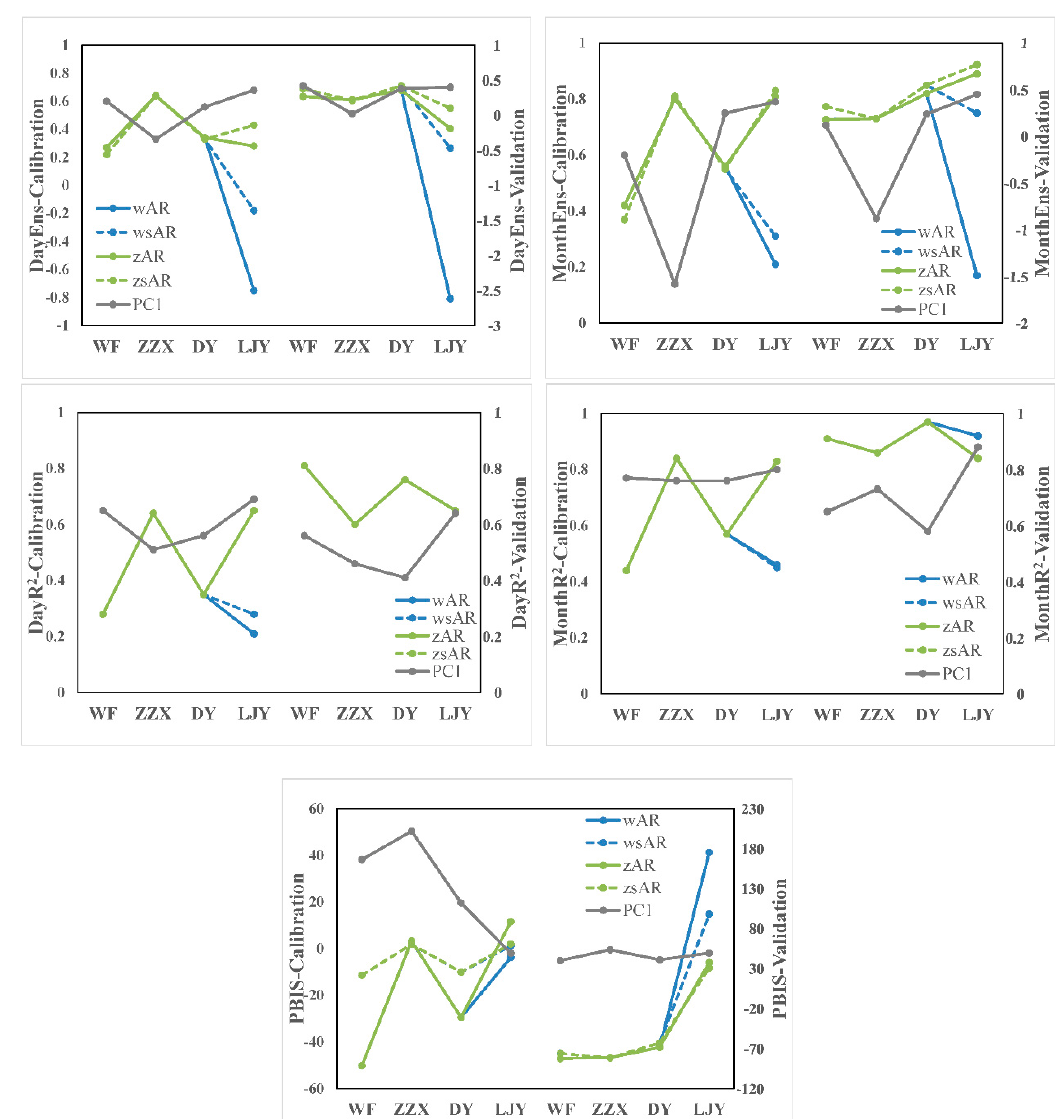
Figure 4. The variation of the area ratio method performance in the four gauged catchments in group PC1. wAR referred to the non-standard area ratio (AR) method when the runoff donor was WF; wsAR referred to the standard AR method when the runoff donor was WF; zAR referred to the non-standard AR method when the runoff donor was ZZX; zsAR referred to the standard AR method when the runoff donor was ZZX. The calibration period referred to the period during which the calculation formula was formed; PC1 referred to the parameter transfer method in clustering based on physical attributes and climatic characteristics (Table 4).